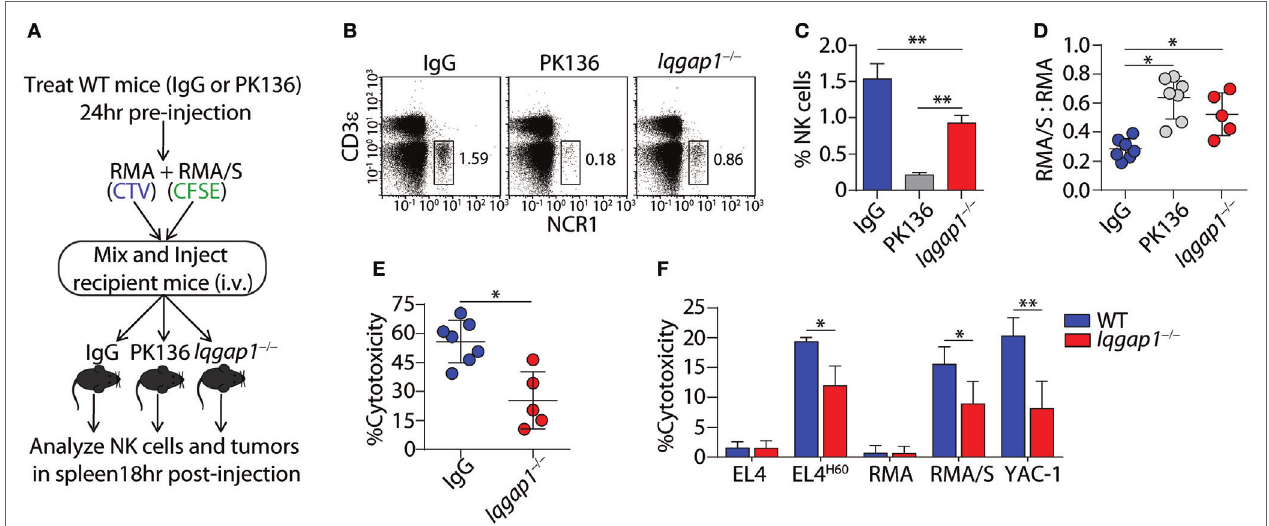
FigUre 3 | IQ domain-containing GTPase-activating protein 1 (IQGAP1) mediates the antitumor response of natural killer (NK) cells in vivo . (a) Diagram of “ missing-self ” tumor clearance model for in vivo evaluation of NK cell function. (B) Representative dot plots and (c) quantification of NK cell (CD3 ε − NCR1 + ) percentages 18 h after tumor inoculation in wild-type (WT), isotype (IgG), or NK-depleted (PK136), as well as Iqgap1 − / − mice. (D) Ratios of fluorescently labeled RMA/S to RMA cells collected from the spleens of antibody-treated WT or Iqgap1 − / − mice 18-h post-inoculation and (e) in vivo cytotoxicity against RMA/S tumors in WT (IgG-treated) and Iqgap1 − / − mice were calculated as described in the Materials and Methods section. (F) Ex vivo cytotoxic potential of WT and Iqgap1 − / − NK cells was assessed by the standard 4-h 51 Cr-release assay. Multiple tumor lines were co-cultured with splenic NK cells isolated from WT or Iqgap1 − / − mice at an effector (E) to target (T) ratio of 10:1. Error bars represent SD using four to seven mice in at least two independent experiments, * p < 0.05 and ** p < 0.01 using two-tailed Student’s t -test (a–e) or two-way ANOVA (F) accounting for multiple